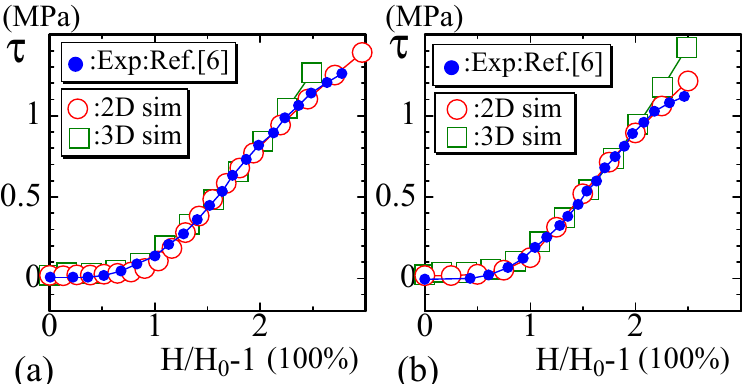
Figure 8. The experimental data are of the periodontal ligament of the molars of rats at ( a ) 6 months and ( b ) 12 months of age [8]. The strain of the toe region is approximately 50%, which is relatively short. For the large-strain region, the experimental data are slightly convex upwards, which is well fitted by the 2D simulation data except in the terminal failure